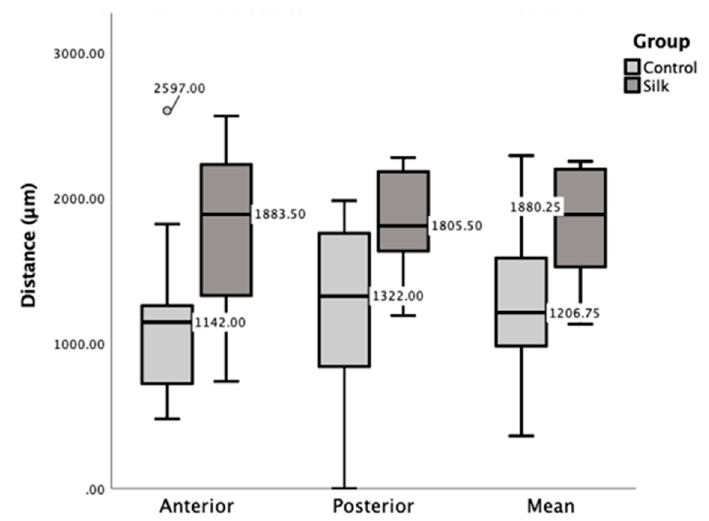
Figure 4. Box-plot showing the distance from implant top to first bone-to-implant contact for implants with silk ligatures (Silk) and pristine implants (Control).